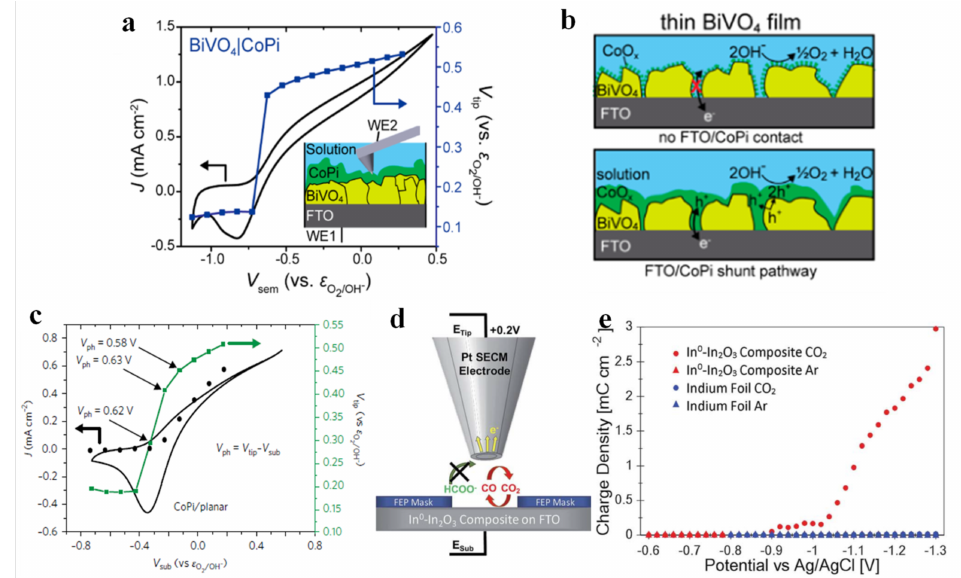
Figure 6. Operando PS − EC − AFM potential stepping experiments. CV for CoPi − coated BiVO 4 (black) and the measured tip potential (V tip , purple) during potential stepping, while illuminated. The inset shows the operational setup ( a ). For thin films of BiVO 4 with low CoPi loading, the catalyst does not significantly shunt to the underlying FTO (top), whereas at high loadings, the catalyst is in contact with both the BiVO 4 and the FTO (bottom) ( b ). Adapted with permission from ref. [101]. Copyright 2018 American Chemical Society. In operando PS − EC − AFM potential-step photoelectrochemical experiments. The measured potential of CoPi on planar hematite ( c ). Adapted with permission from ref. [102]. Copyright 2017 Springer Nature. Schematic of the SG-TC SECM experiment showing the collection of CO but not COOH on a Pt tip electrode ( d ). Product collection charge density as a function of the potential applied to the catalytic electrode for both the In 0 − In 2 O 3 composite and the In foil electrode in both CO 2 − saturated and Ar − saturated 0.1 M Na 2 SO 4 ( e ). Adapted with permission from ref. [104]. Copyright 2017 The Royal Society of